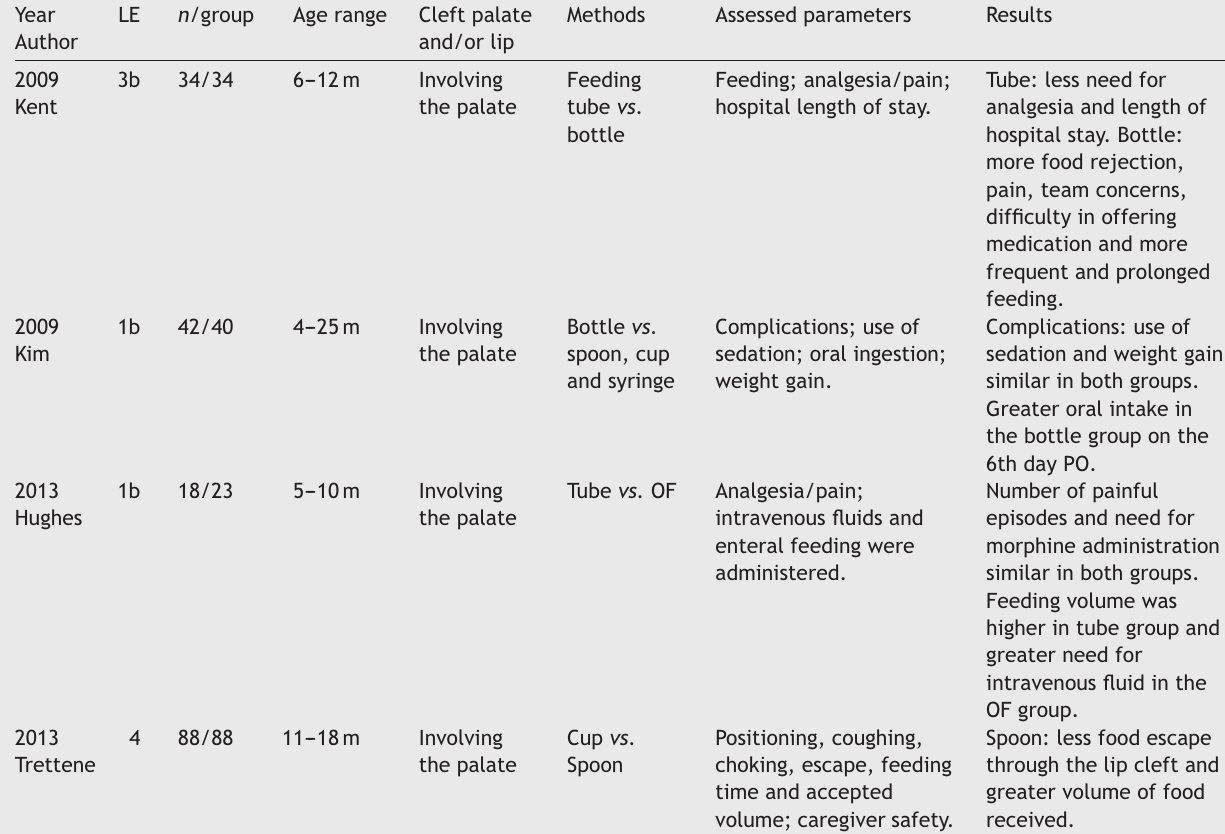
Characterization of studies comparing feeding methods in the postoperative period of surgical repair of cleft palate associated or not associated with lip